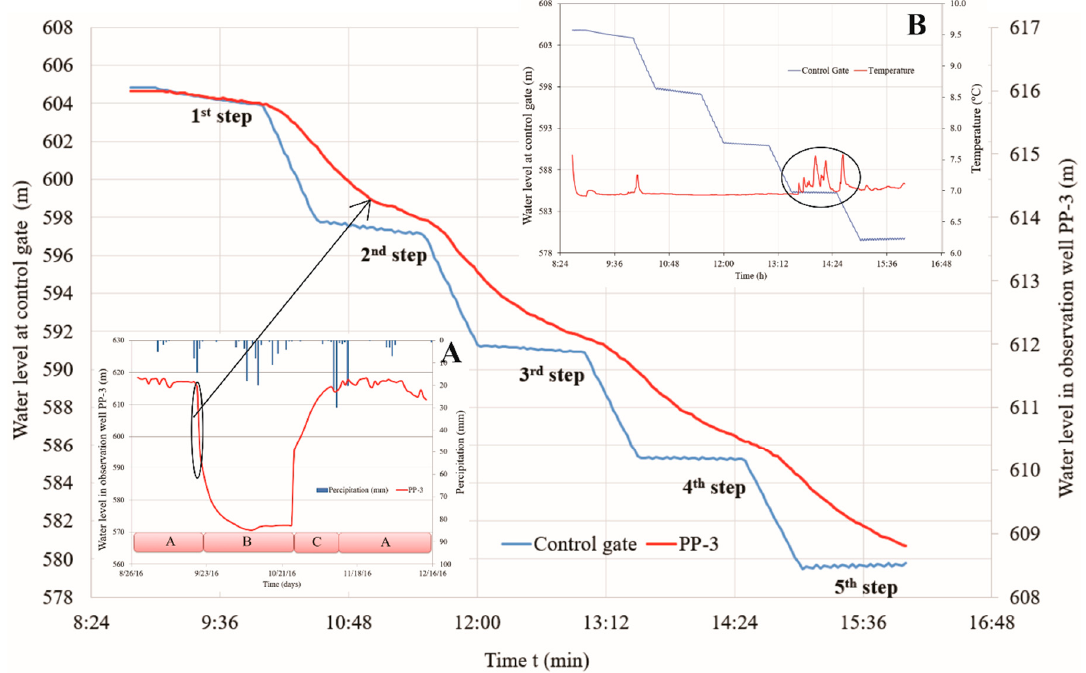
Figure 4. Comparative diagram of groundwater level in PP-3 and at the control gate (CG) while there were water losses from the tunnel, showing the entire period of monitoring of groundwater level in PP-3 ( A ) and water temperature at the control gate ( B ).